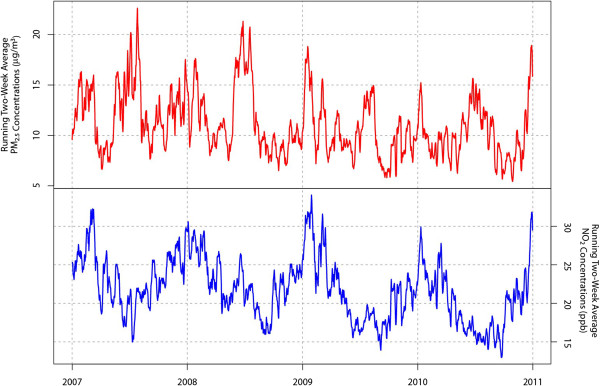
Time series for PM2.5 and NO2.